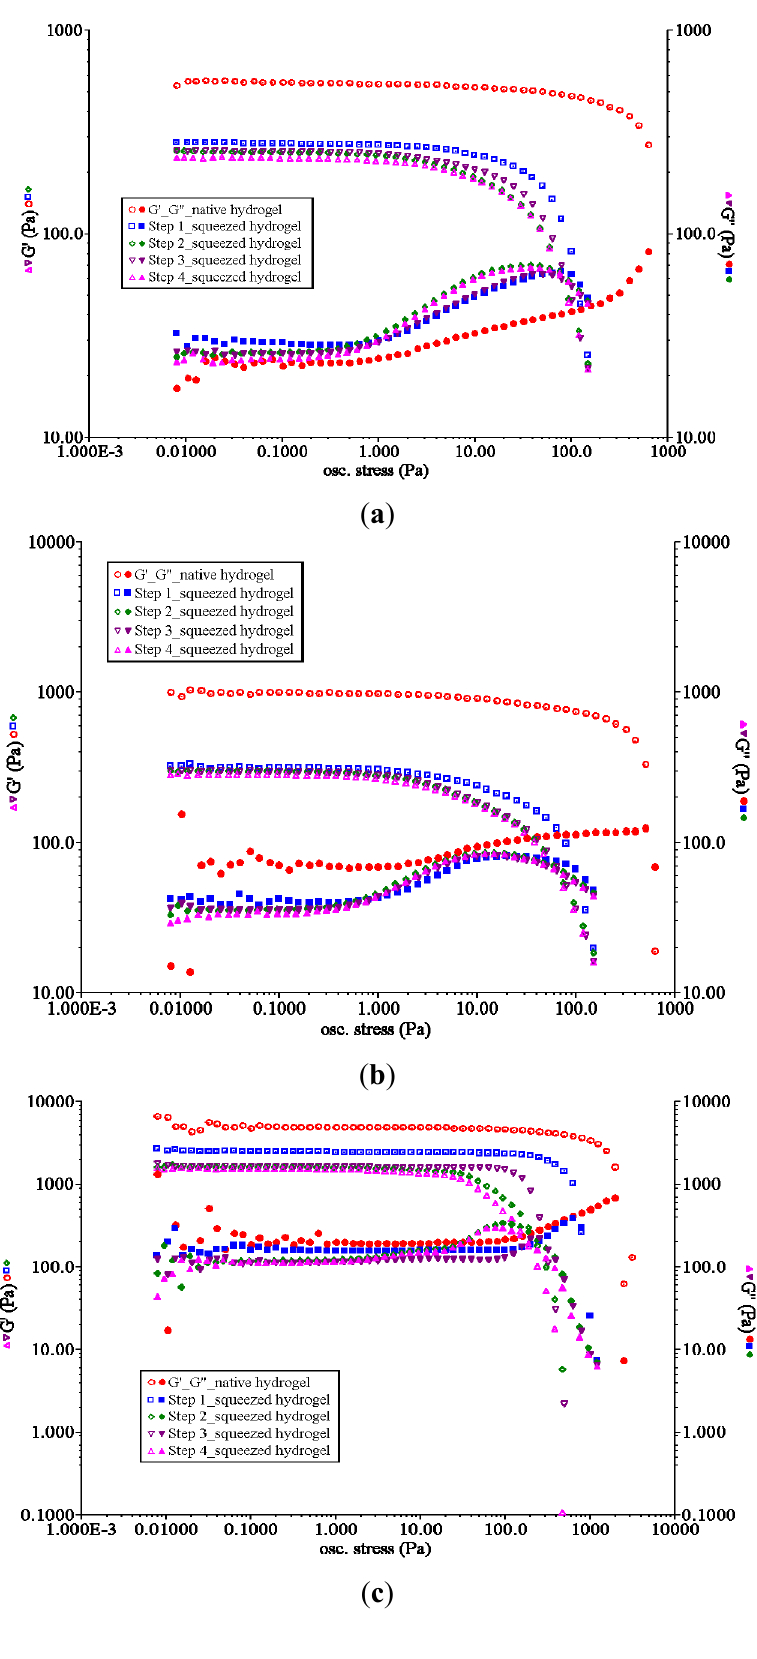
Figure 3. Stress sweep test performed on ( a ) CMC hydrogel; and ( b ) Hyal hydrogel; ( c ) CHT hydrogels, native and after being squeezed through a syringe. The figure shows the G’ and G” values vs . oscillation stress for each step of the